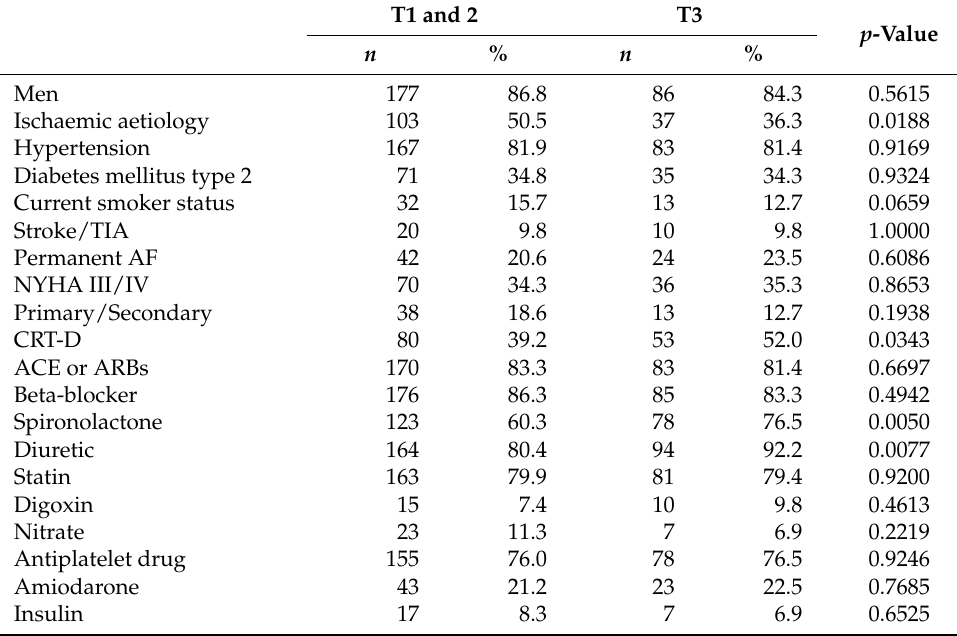
Table 2. Baseline medical and medicine characteristics of participants in both